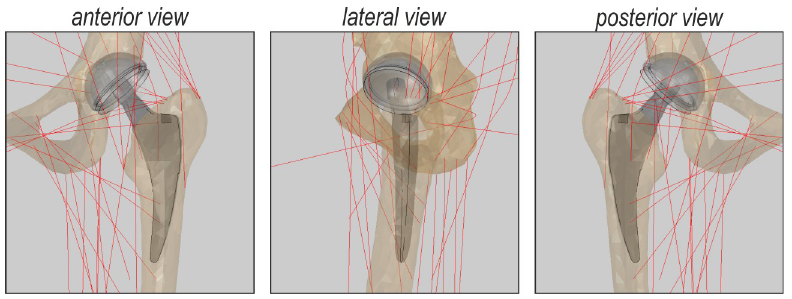
Fig 2. Stem position. The red lines denote the Hill-type muscle